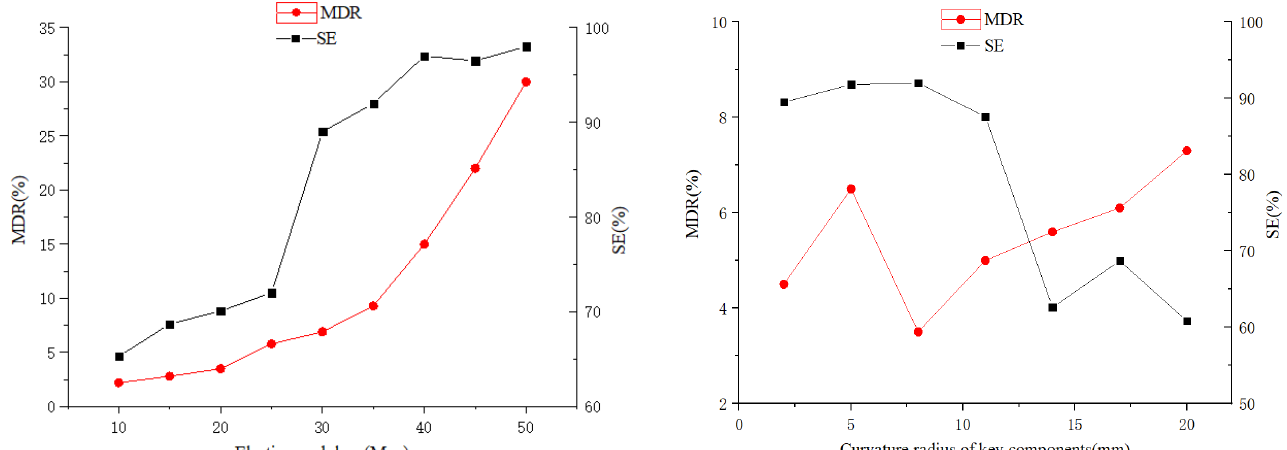
Figure 5. Cloud maps of wear tests for different materials ( a ) cloud map of surface wear for rubber, ( b ) cloud map of surface wear for Nylon, ( c ) cloud map of surface wear for wood(cypress), and ( d ) cloud map of surface wear for Polyurethane.